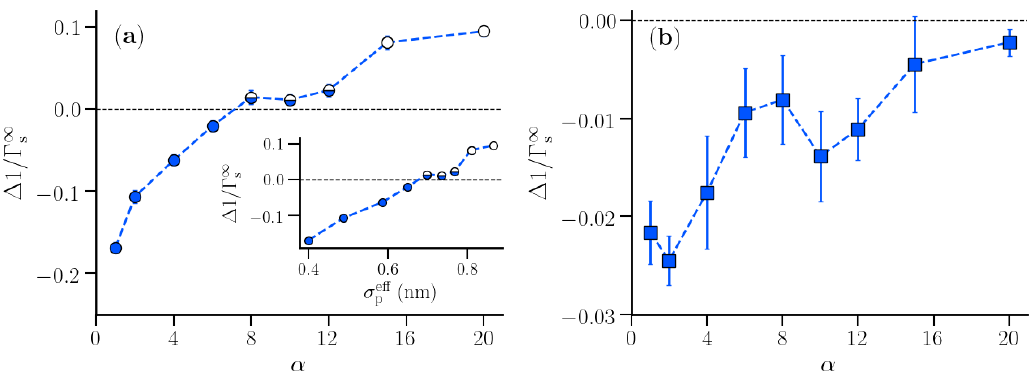
Figure 6. ∆ 1/ Γ ∞ s profiles for the first ( a ) and second ( b ) polymer hydration shell for various strengths α of the repulsive interaction. The inset in ( a ) shows the variation of ∆ 1/ Γ ∞ s as a function of σ eff p . In ( a ), the data points are grouped based on their variation with α (see text). The error bars are calculated over four distinct windows in the production trajectory. The lines are guide to the